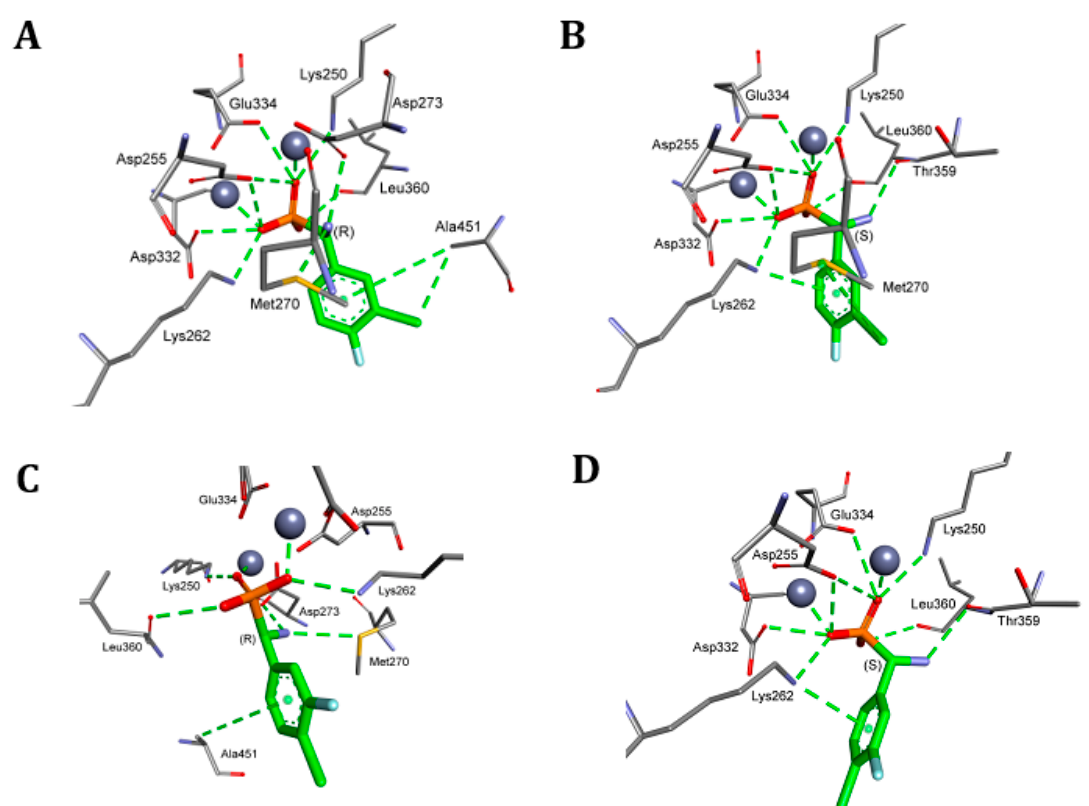
Figure 5. Mode of binding of both enantiomers of representative analogues of phenylglycine by bovine lens leucine aminopeptidase. A : S -isomer, B : R -isomer of compound 7 , C : S -isomer D : R -isomer of compound 8.